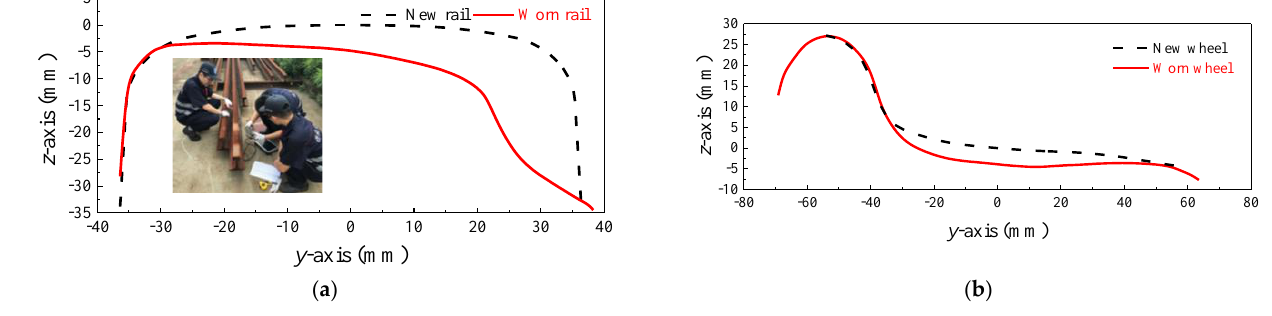
Figure 17. Wear profile: ( a ) worn rail profile; ( b ) worn wheel profile.